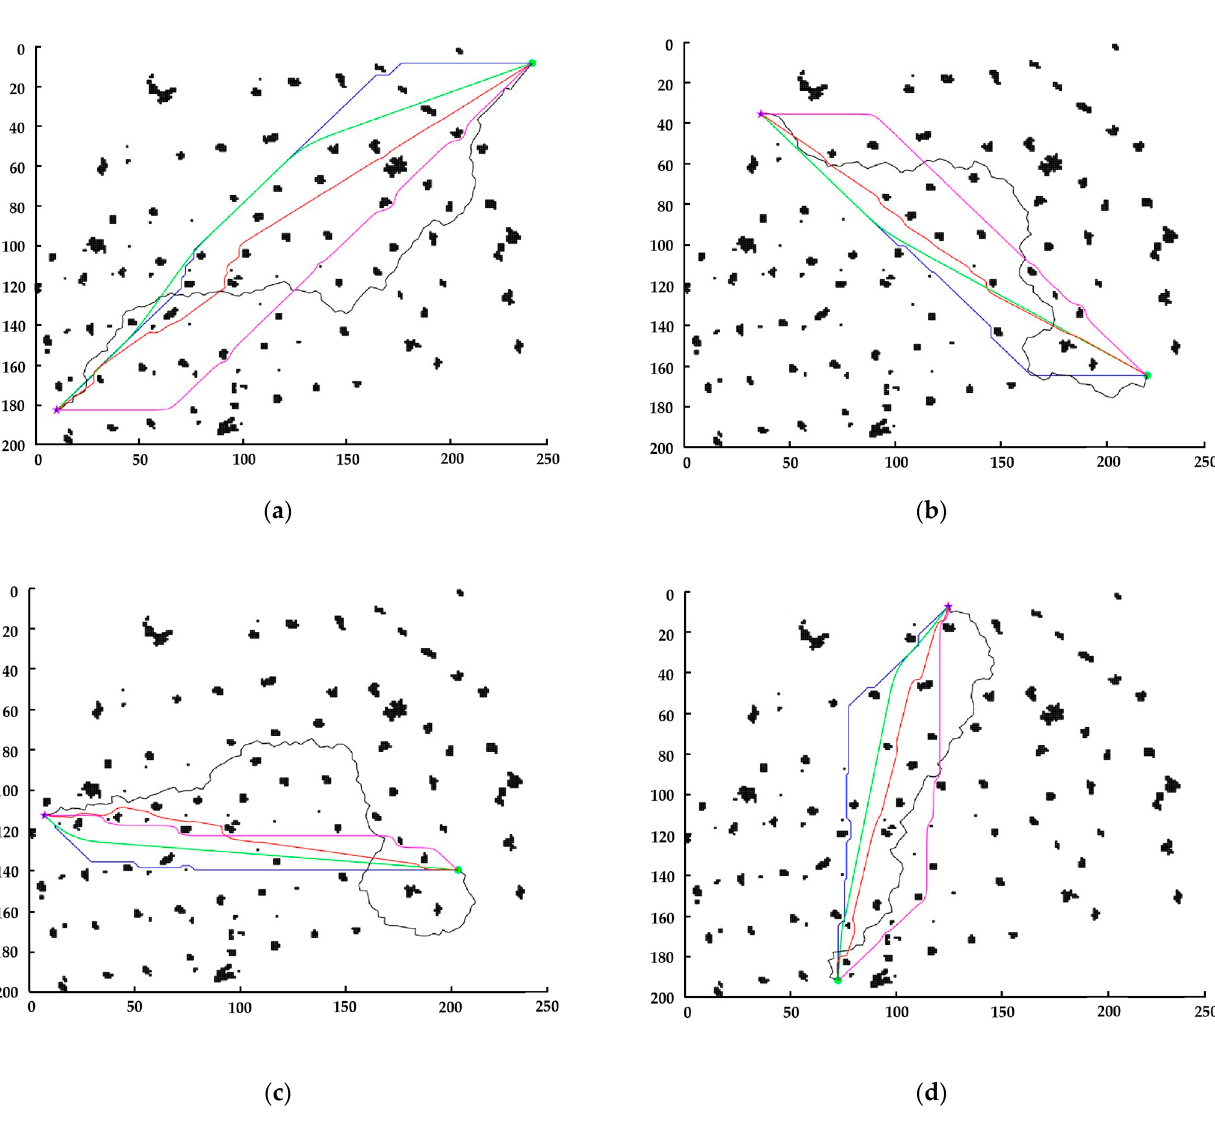
Note: Where blue path trajectory represents traditional A* algorithm, green represents the improved A* algorithm in this paper, purple represents the improved A* algorithm in literature[38], red represents the APF algorithm, and black represents the RRT algorithm. Figure 8. Path planning trajectory with di ff erent starting and target point positions. ( a ) start point coordinates (10, 182), end point coordinates (240, 8); ( b ) start point coordinates (38, 35), end point coordinates (220, 162); ( c ) start point coordinates (8, 112), end point coordinates (206, 138); ( d ) start point coordinates (72, 194), end point coordinates (125, 8);